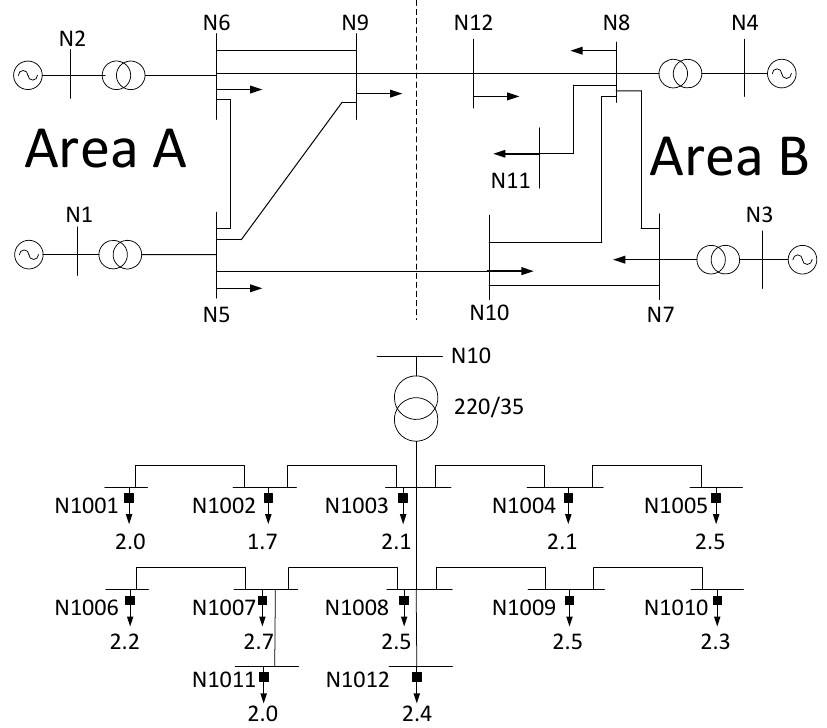
Figure 7. Structure of the test power system.